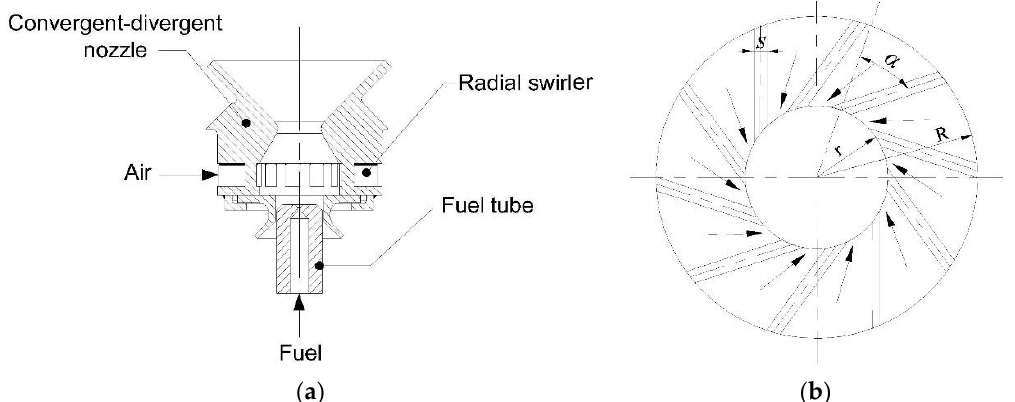
Figure 1. ( a ) Swirl convergent-divergent nozzle; ( b ) swirler.